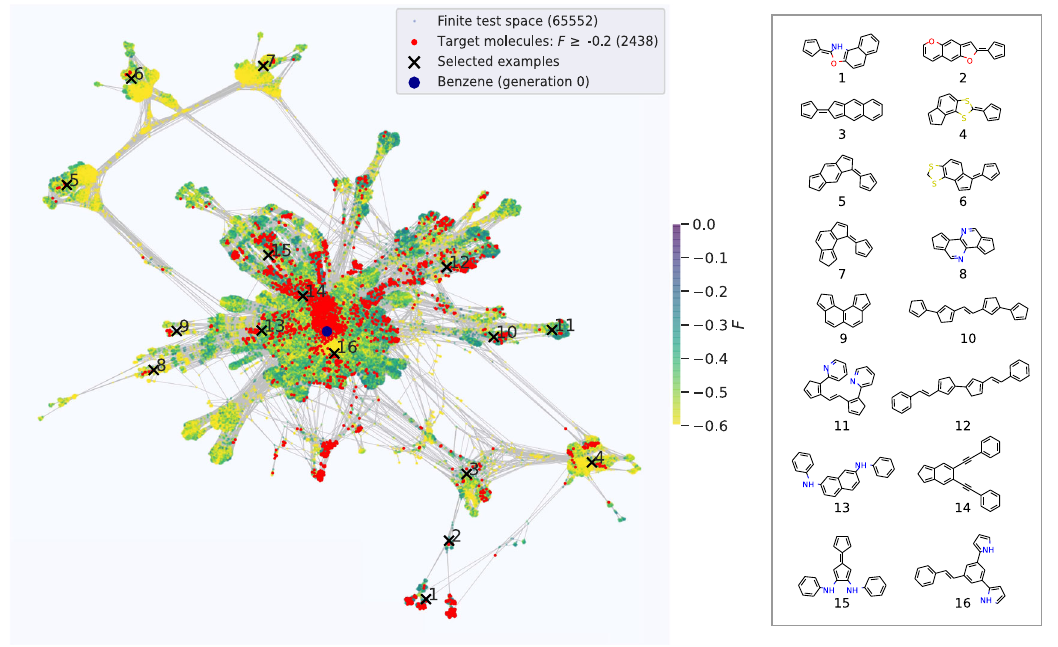
Fig. 2 Finite OSC test space. Left panel: Chemical space network (CSN) representation of the fi nite OSC test space of 65.552 unique molecules generated by exhaustive application of all morphing operations up to 14 times. Each molecule is surrounded by morphing-related analogs (see text). Benzene as the smallest base molecule is colored in blue. All other molecular nodes are colored according to their fi tness function F as calculated at the semi-empirical density-functional tight-binding level. 2438 red nodes form the target discovery group of top-performing molecules with high fi tness F ≥ − 0.2. Right panel: Example molecules from the top-performing group, chosen randomly from different areas of the CSN to illustrate the structural diversity contained in the test